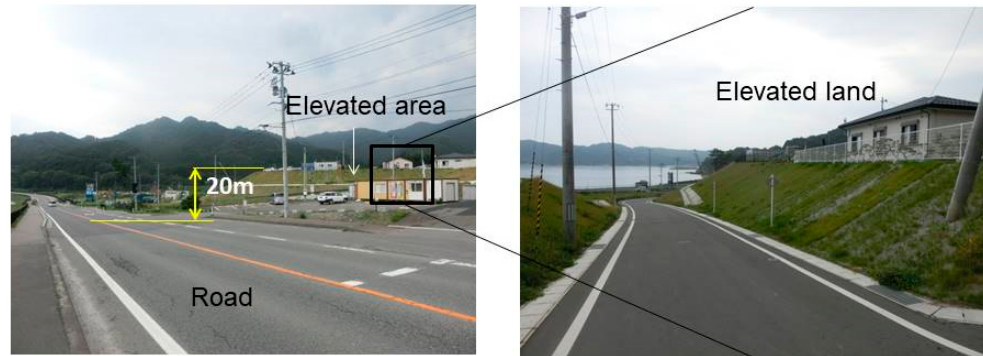
Figure 9. Significant parts of Kirikiri were elevated, as part of the multi-layer safety defence. Picture shows houses constructed on elevated land.